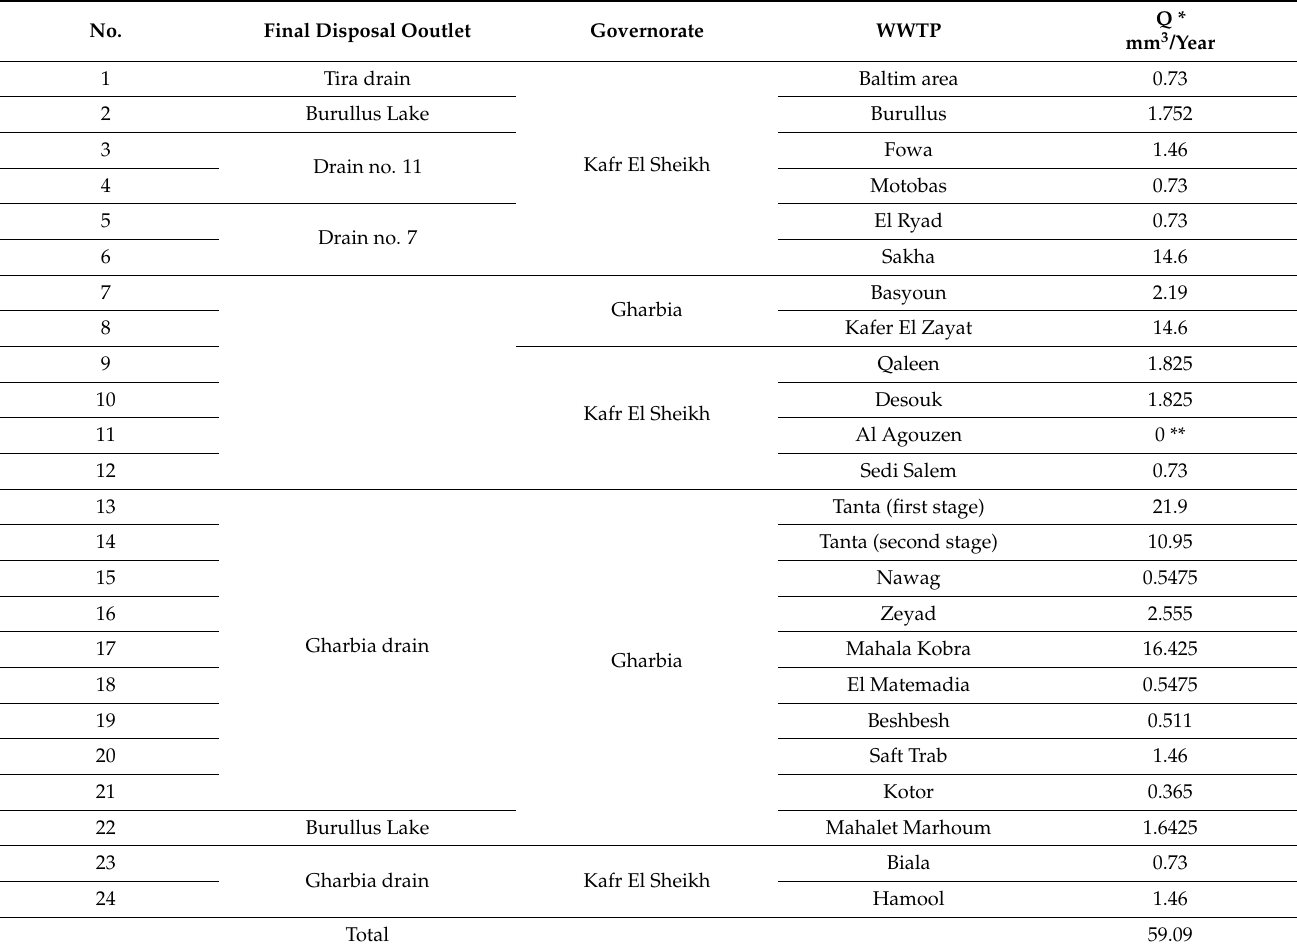
Table 5. WWTPs discharging their effluents to agricultural drains leading to Lake Burullus (data obtained from Holding Company for Water and Wastewater (HCWW)).